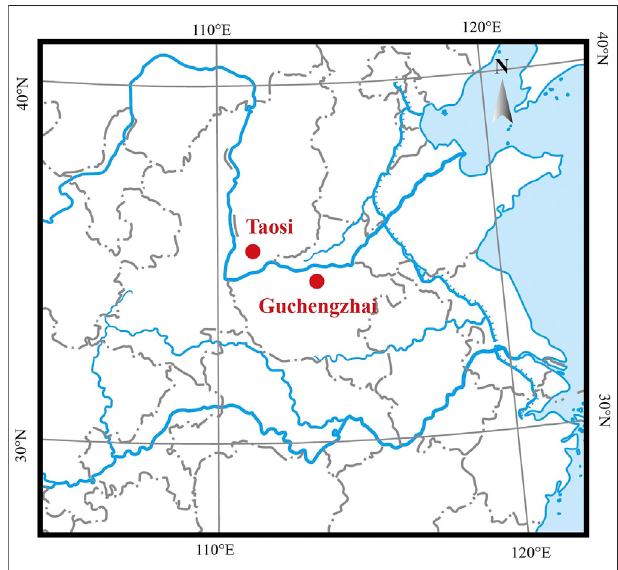
FIGURE 1 | Location of the Taosi and Guchengzhai archaeological sites (red